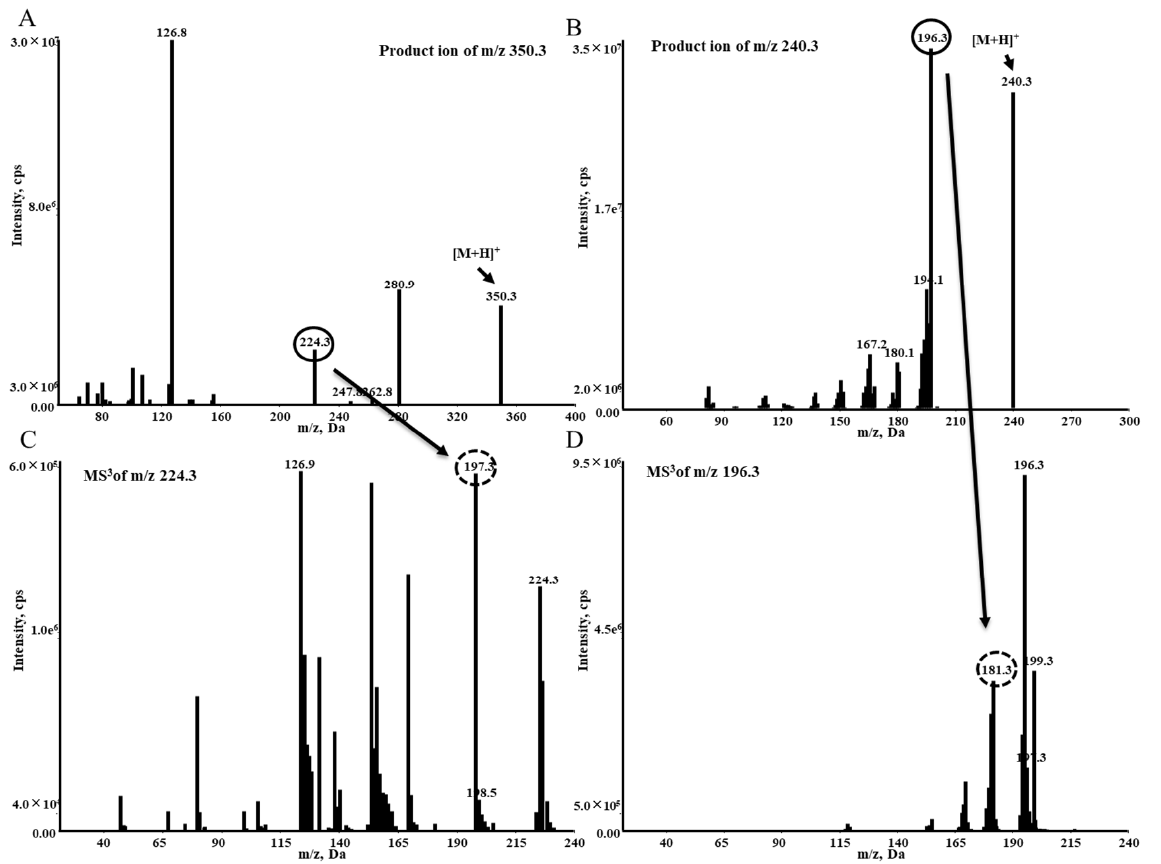
Molecules 2022 , 27 , x FOR PEER REVIEW 4 of 12 Figure 1. Representative product ion (MS 2 ) for ( A ) voriconazole and ( B ) carbamazepine-d2,15N and MS 3 for ( C ) voriconazole and ( D ) carbamazepine-d2,15N.